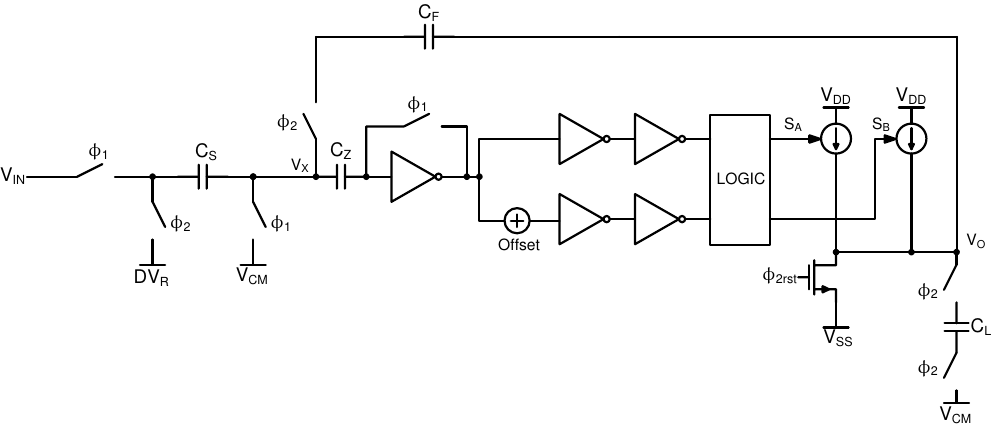
Figure 3. A switched-capacitor circuit using an inverter-based zero-crossing-detectors (ZCD)